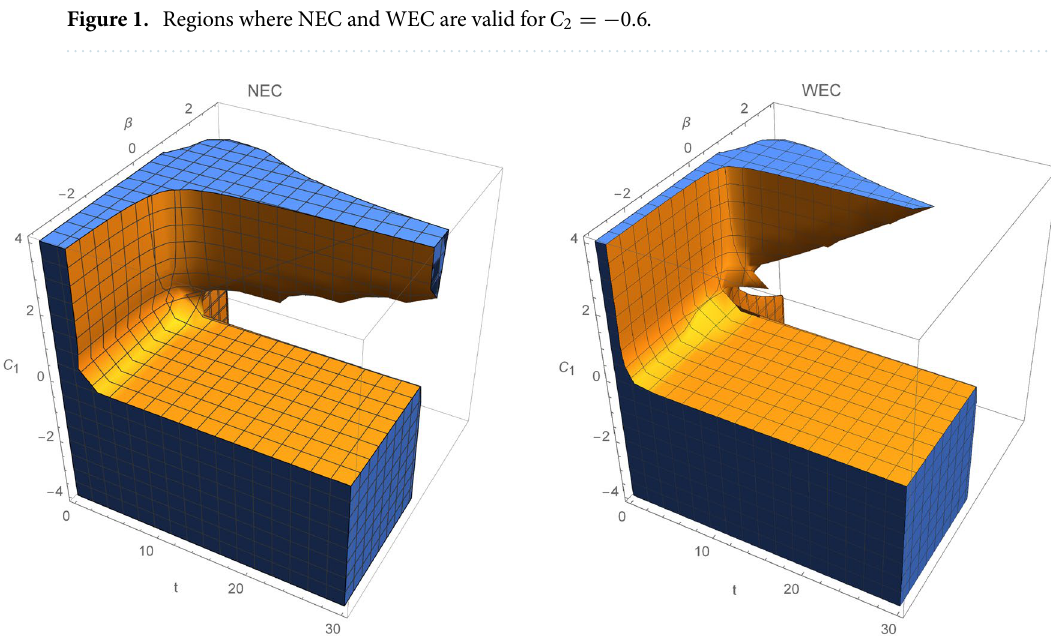
Figure 1. Regions where NEC and WEC are valid for C 2